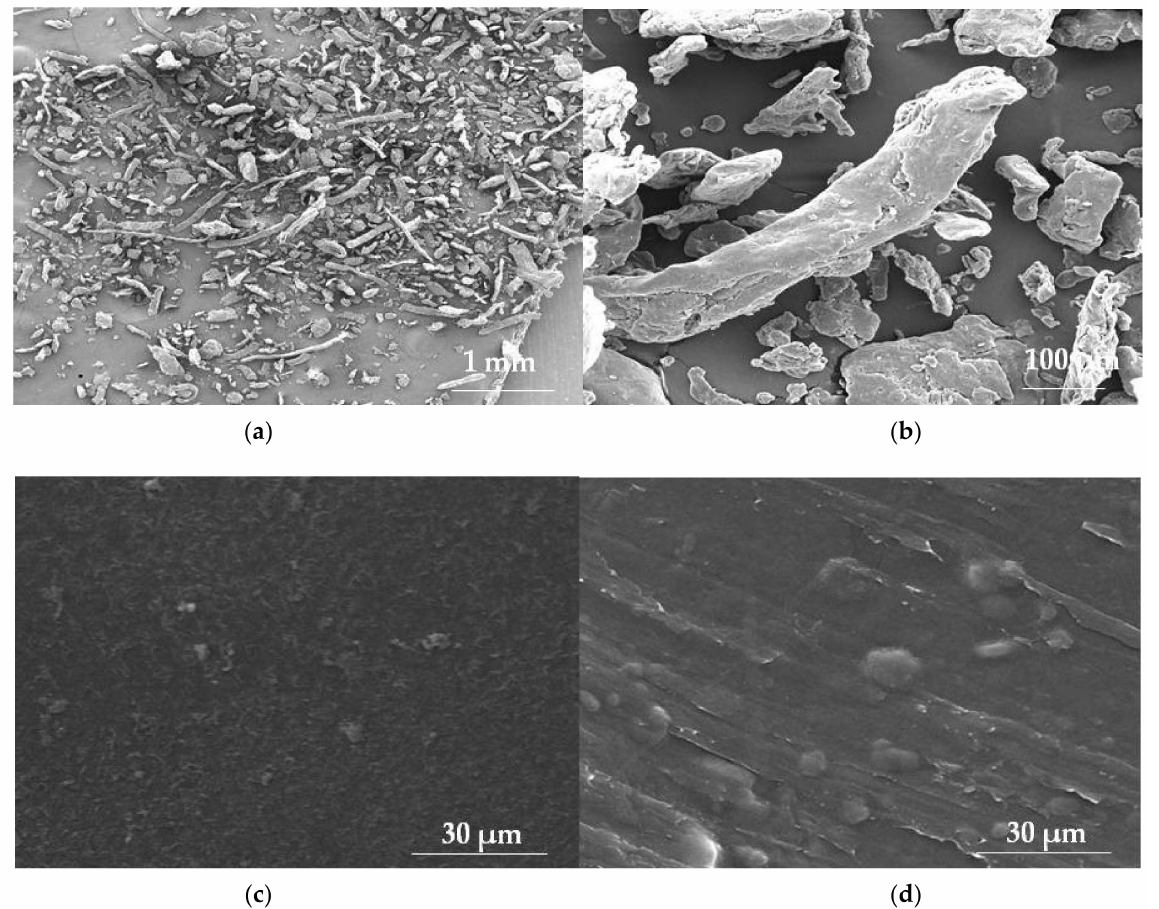
Figure 2. SEM picture of HPMC (Pharmacoat 606) powder under magnification ( a ) 100 × , ( b ) 1000 × and ODFs’ piece made of HPMC (Pharmacoat 606) placebo under magnification, ( c ) 5000 × and with incorporated drug under magnification, ( d ) 5000 × (photographs of the authors made with Inspect™S50, FEI Company, Hillsboro, OR, USA).